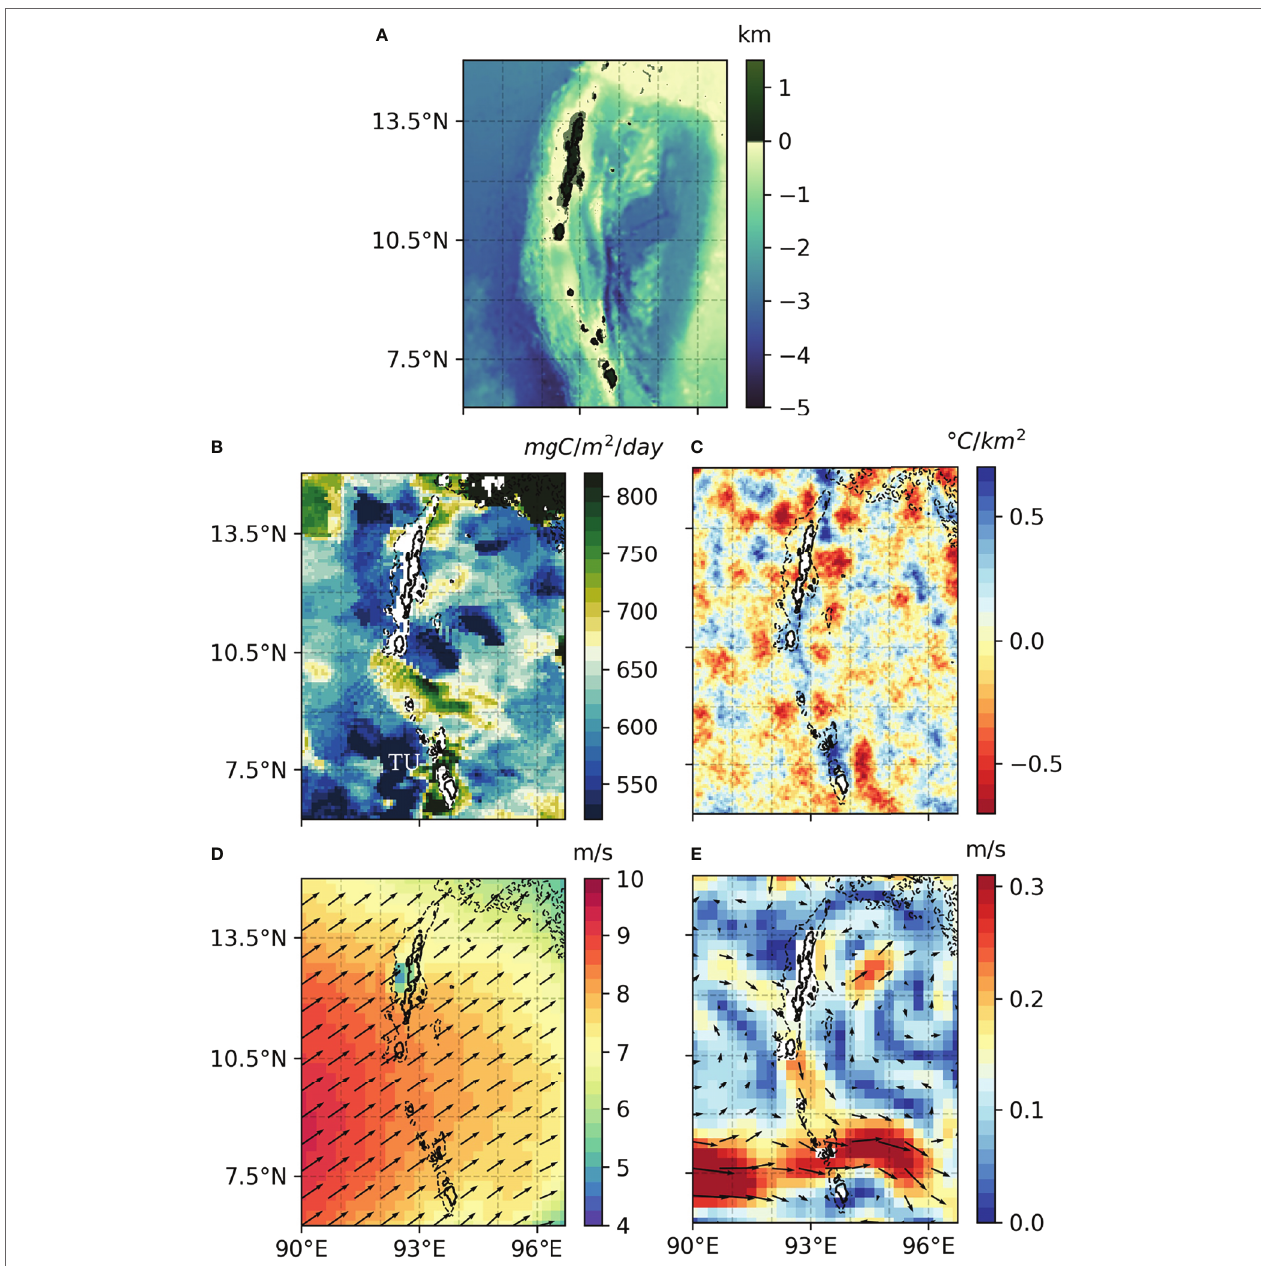
FIGURE 6 | Andaman and Nicobar islands (A) Topography, (B) NPP, (C) SST Laplacian, (D) Wind Speed, (E) OSCAR currents, June 2013. Black dashed line represents the 100 m depth isoline. TU stand for Topographic